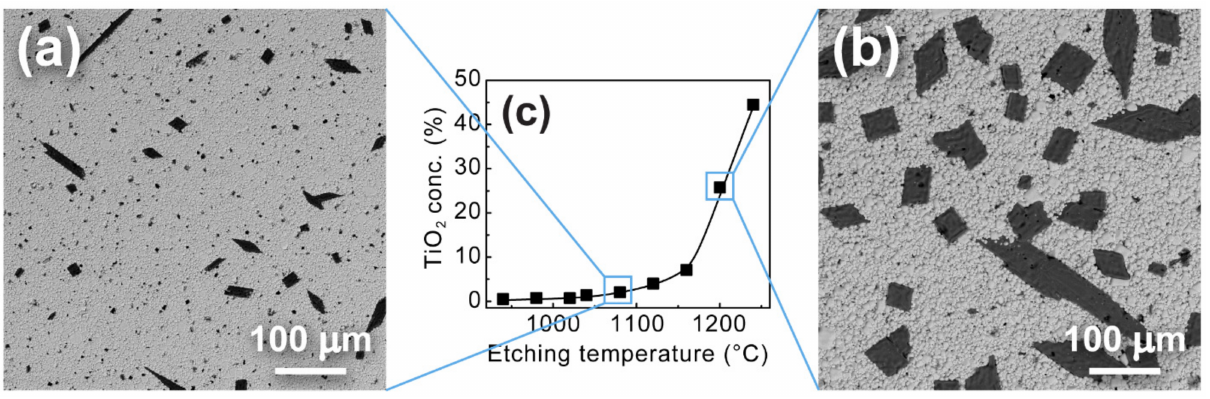
Figure 4. Surface of NBT-Eu ceramics with TiO 2 inclusions, thermally treated at 1080 ◦ C ( a ) and 1200 ◦ C ( b ), and concentra- tion of TiO 2 inclusions as a function of thermal treatment temperature ( c ).